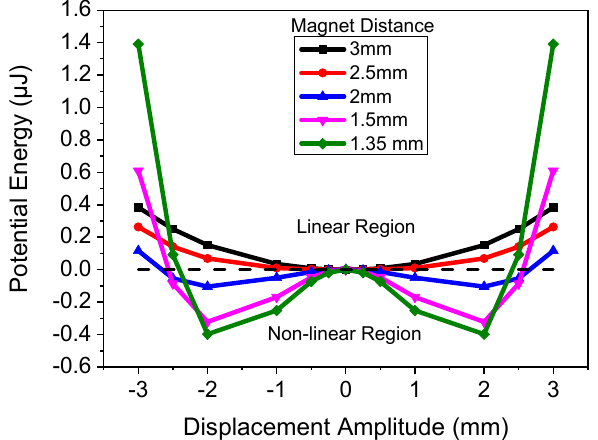
Figure 5. Numerical model of potential as a function of magnet spacing.